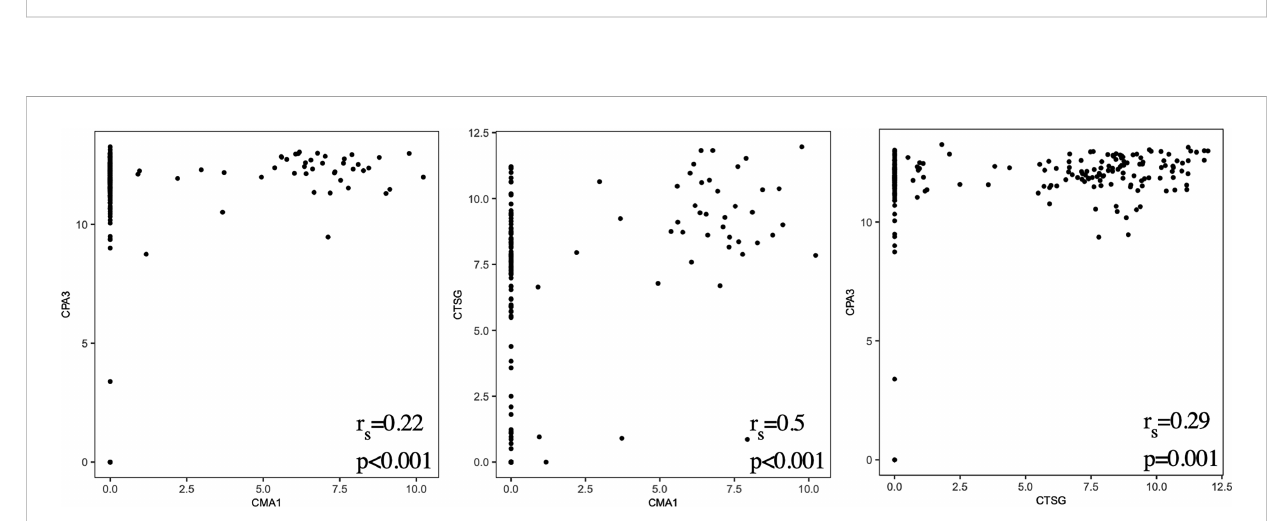
FIGURE 4 Unbiased clustering of the cells from one representative donor using PCA (A, B) , UMAP (C) , and tSNE (D) .